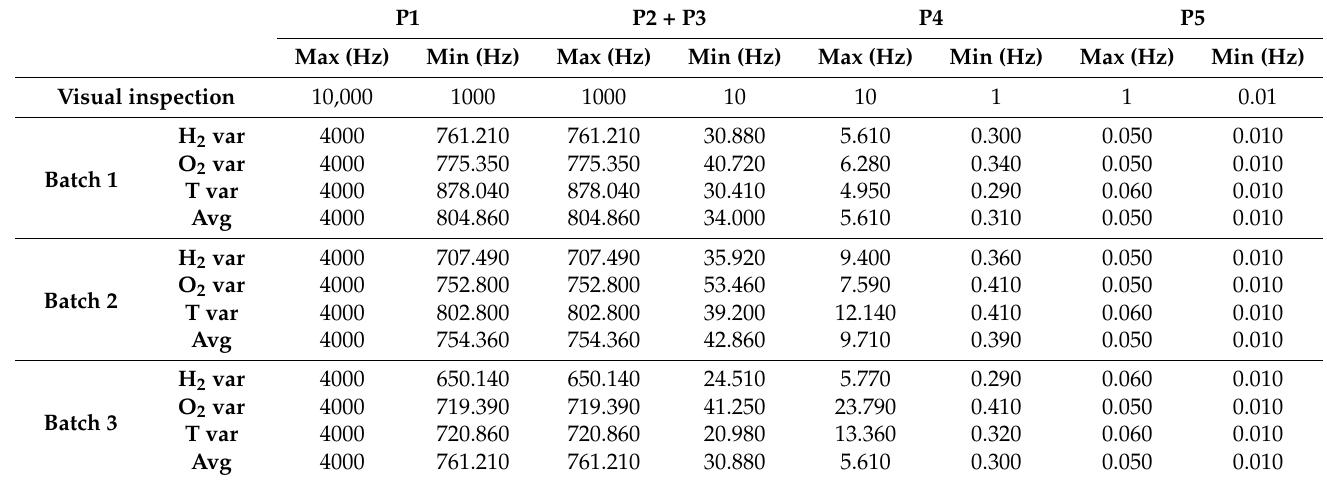
Figure 9. Comparison of frequency ranges of each process. ( a ) Visual inspection of DRT peaks. ( b ) Calculated by the tool. Table 3. Frequency ranges calculated for each batch at every parameter